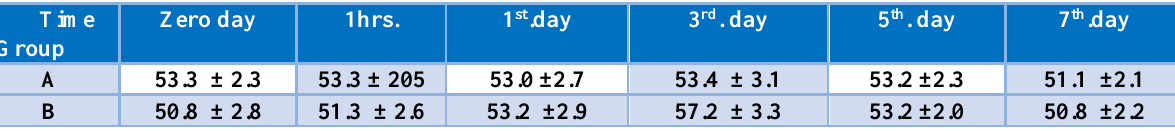
There are no significant differences in the mean values between the different groups A, B in the different periods. Table, 4: Total bilirubin (mg/dl)